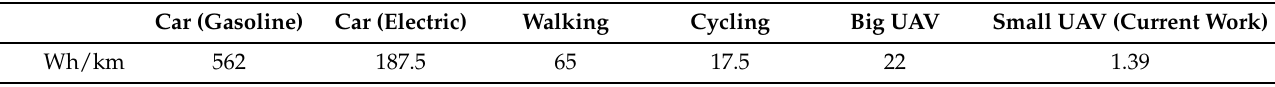
Table 8. Comparison of UAV-based operation vs manual intervention